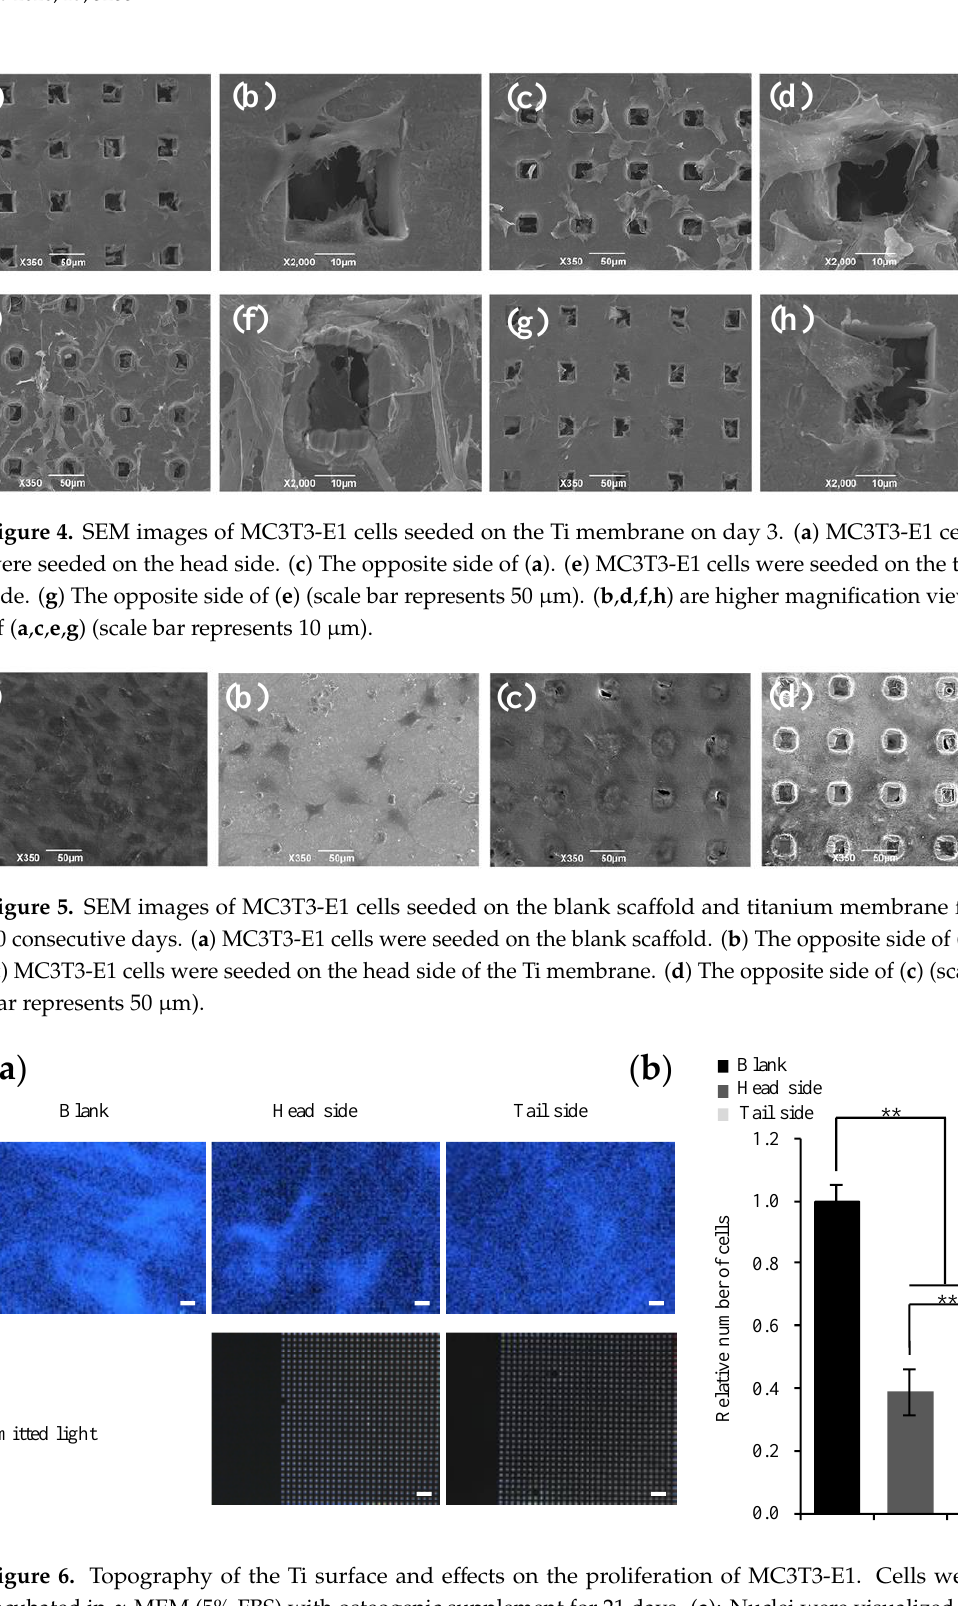
Figure 6. Topography of the Ti surface and effects on the proliferation of MC3T3-E1. Cells were incubated in α-MEM (5% FBS) with osteogenic supplement for 21 days. ( a ): Nuclei were visualized by staining with DAPI (blue). Scale bars represent 250 µm. ( b ): Stained areas in panel ( a ) were quantified, and relative expression was plotted by setting the value of DAPI in blank as 1. Representative data of three separate experiments are shown as the mean ± standard deviation of sextuplicate assays. The significance of di ff erences is shown (** p <